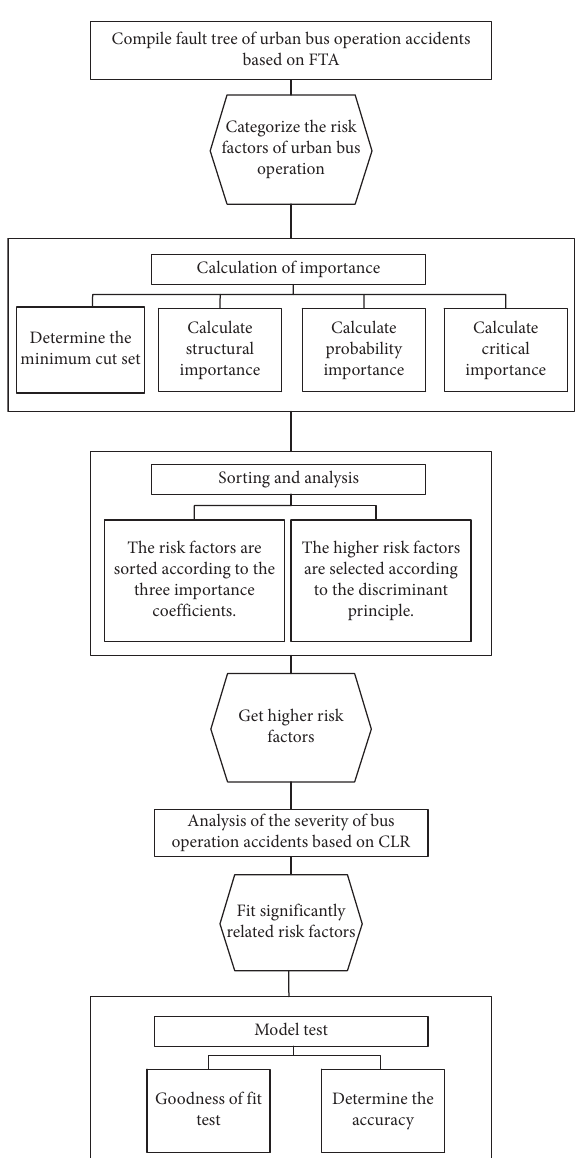
Figure 1: FTA-CLR model analysis